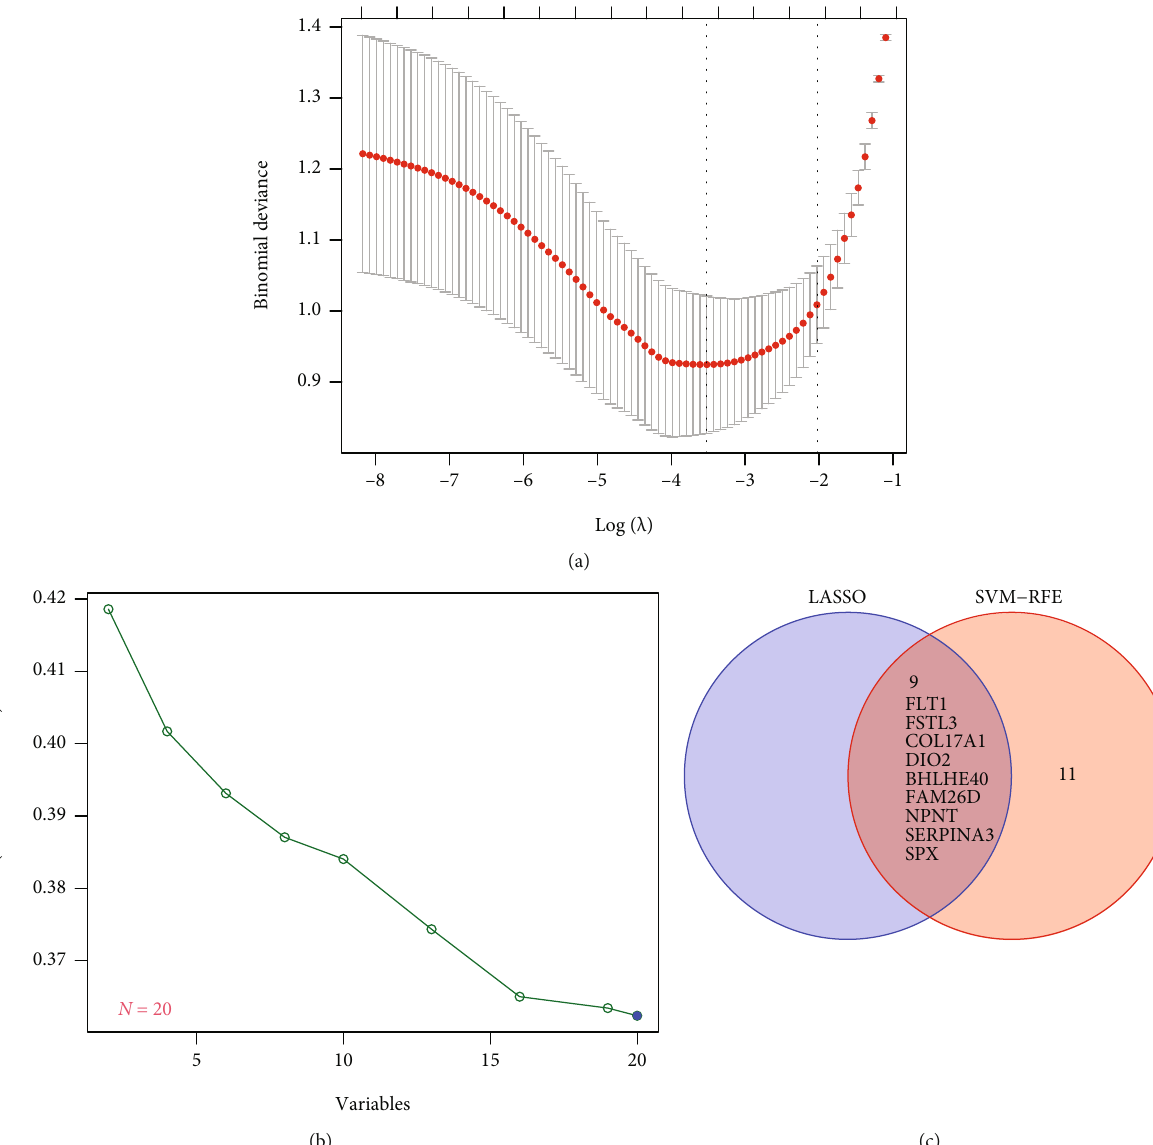
Figure 3: Selection procedure of diagnostic markers for preeclampsia diagnoses. (a) Tuning feature selection in the LASSO model. (b) An illustration of biological marker screening through the SVM-RFE arithmetic. (c) Venn graph presenting 4 diagnostic biomarkers shared by the LASSO and SVM-RFE arithmetic